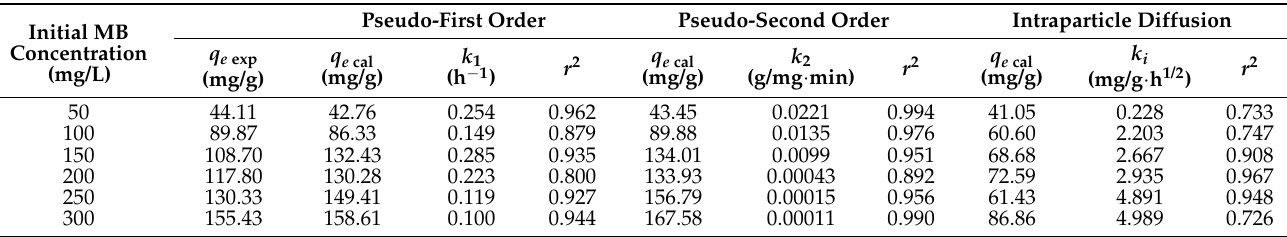
Table 1. Adsorption kinetic model data from different initial